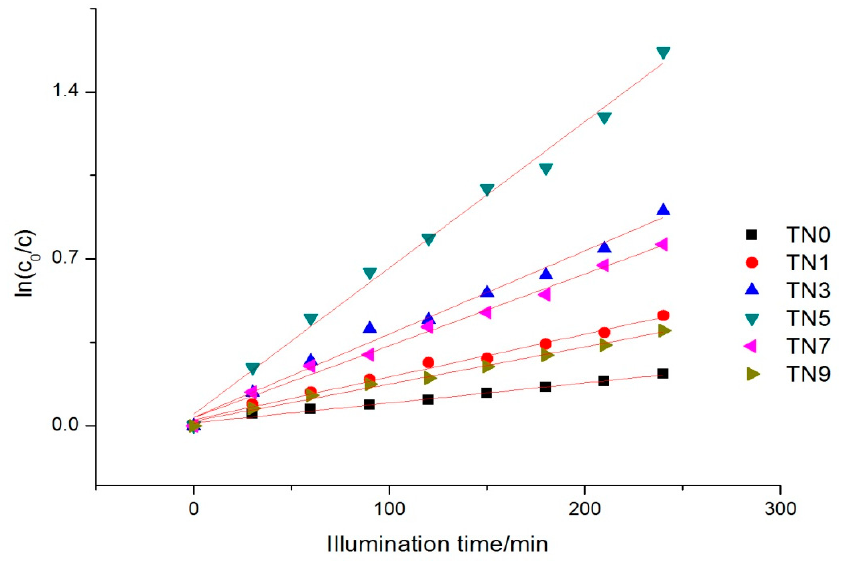
Figure 7. Reaction kinetics trend under visible light.